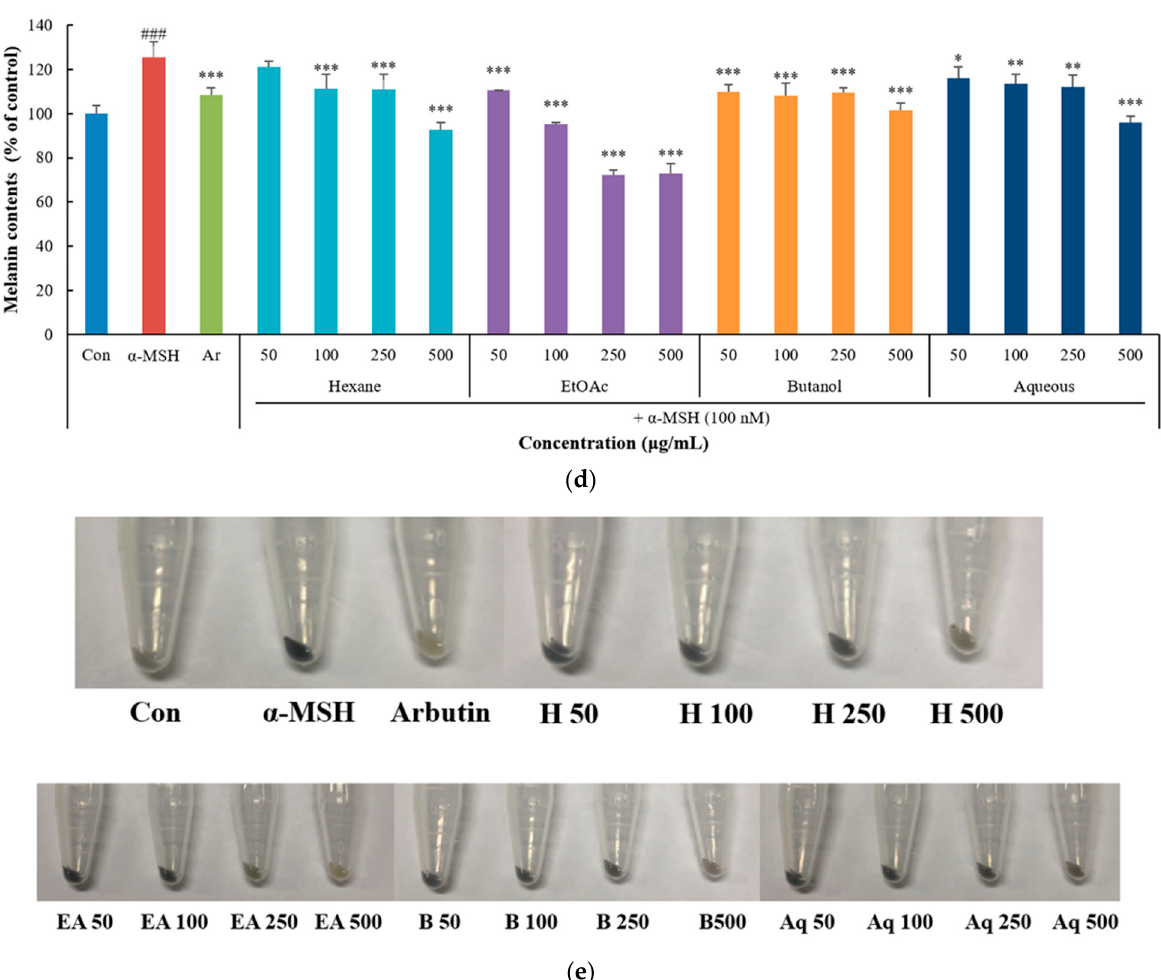
Figure 2. ( a ) Effect of P. thunbergiana L. EtOH extracts on the cell viability of B16F10 melanoma cells. Cells were treated with 10–1000 µg/mL P. thunbergiana L. EtOH extracts. ( b ) Effect of P. thunbergiana L. fractions on cell viability in B16F10 melanoma cells. Cells were treated with 10–1000 µg/mL P. thunbergiana L. fractions. * p < 0.05 and ** p < 0.01 compared with the control. ( c ) Effect of P. thunber-